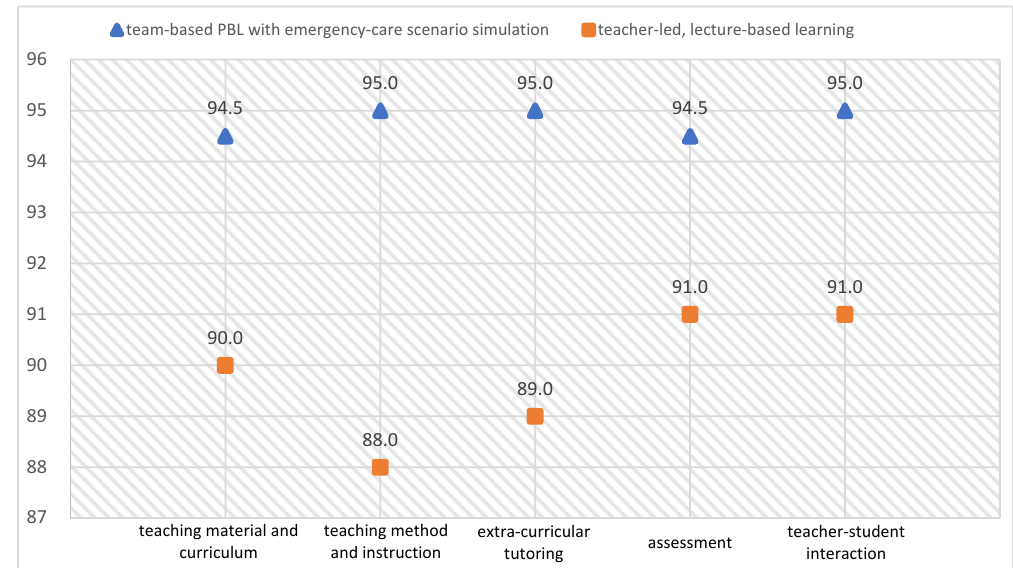
Figure 2. A comparison of the students’ course and teacher evaluations.